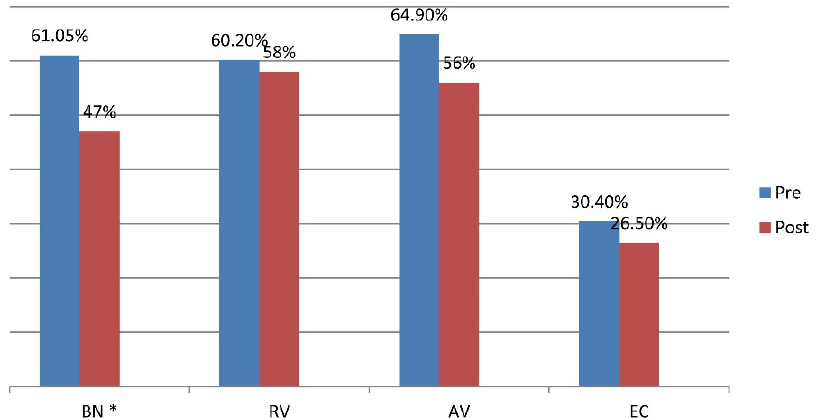
Figure 2 - Mean performance of individuals on each APHAB subscale before and after auditory training. Background noise (BN), Reverberation (RV), Aversiveness (AV), Ease of communication (EC). Statistically significant